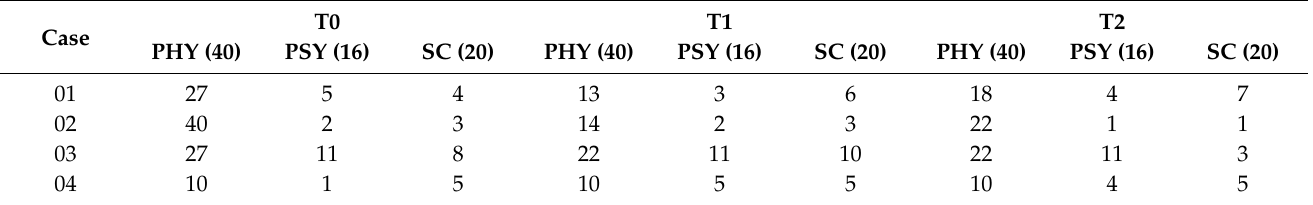
Figure 3. Box plots figure of the OHIP-EDENT-J at each time point. The black dots represent the distribution of raw data. T0: before the clinical remount. T1: immediately after the clinical remount. T2: 1 week after the clinical remount. Statistical analysis was performed with the Wilcoxon sign-rank test. Predetermined level of significance: p < 0.05 (*). Table 3. All data acquired from the OHIP-EDENT-J questionnaire were further divided into three major factors. T0: before the clinical remount. T1: immediately after the clinical remount. T2: 1 week after the clinical remount. Phy (40): Physical impact. The total score of this subscale was 40. Psy (16): Psychological impact. The total score of this subscale was 16. SC (20): Social impact. The total score of this subscale was 20.